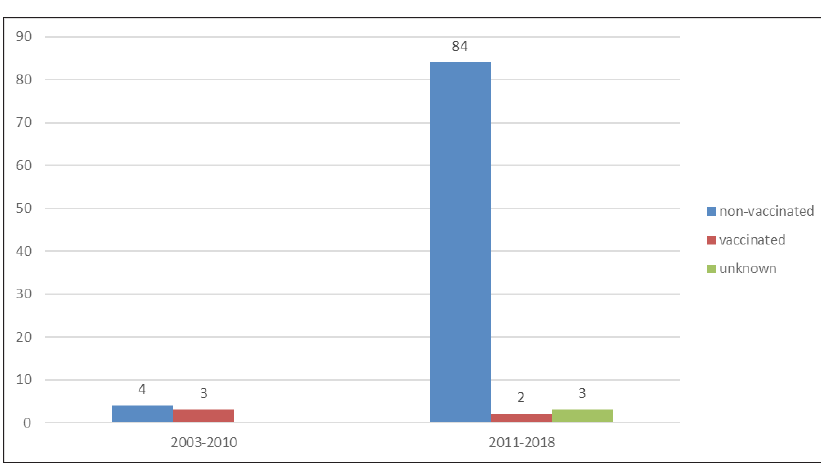
Fig. 4. Number of NMT cases according to the history of